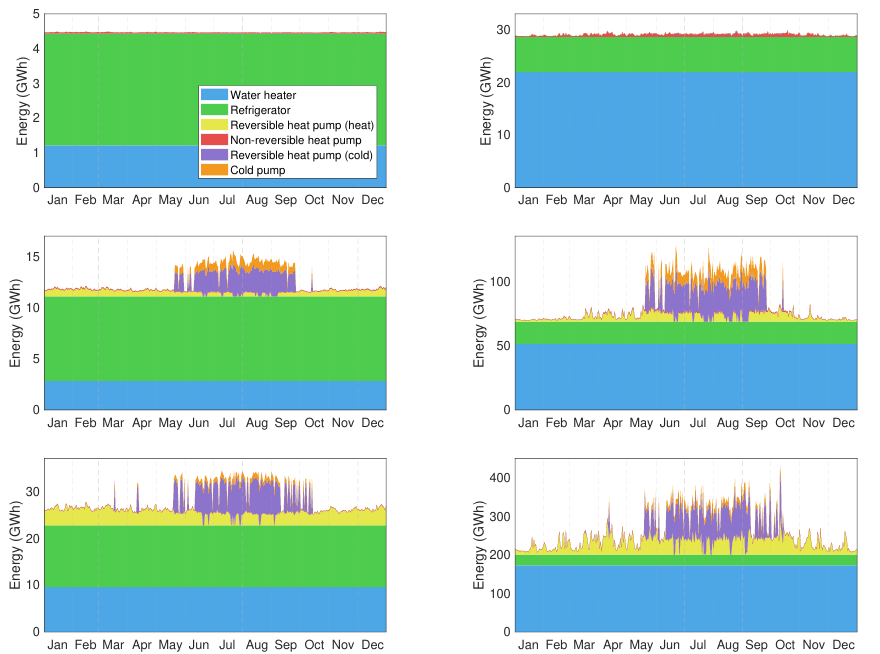
Figure 4. Charging capacity ( left ) and discharging capacity ( right ) in North Atlantic, Continental, and Mediterranean climate areas in 2019.